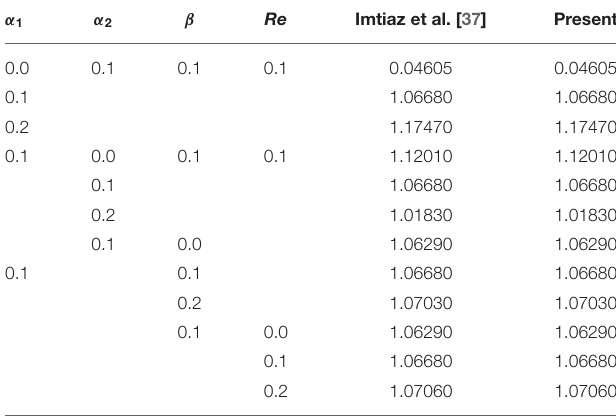
TABLE 3 | Comparison of Re 0.5 C f for different values when M α 1